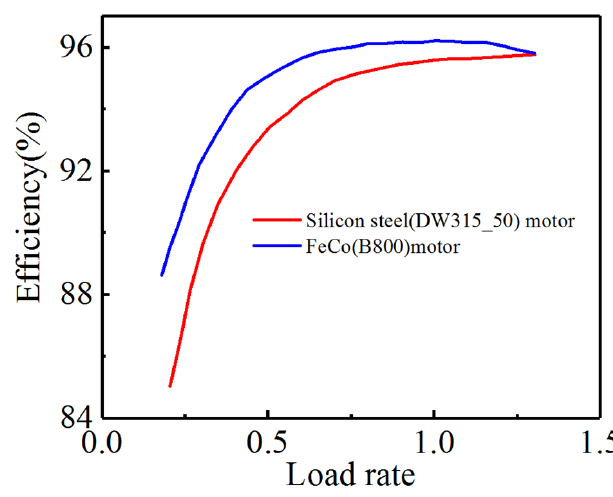
Figure 9. Efficiency comparison curve.